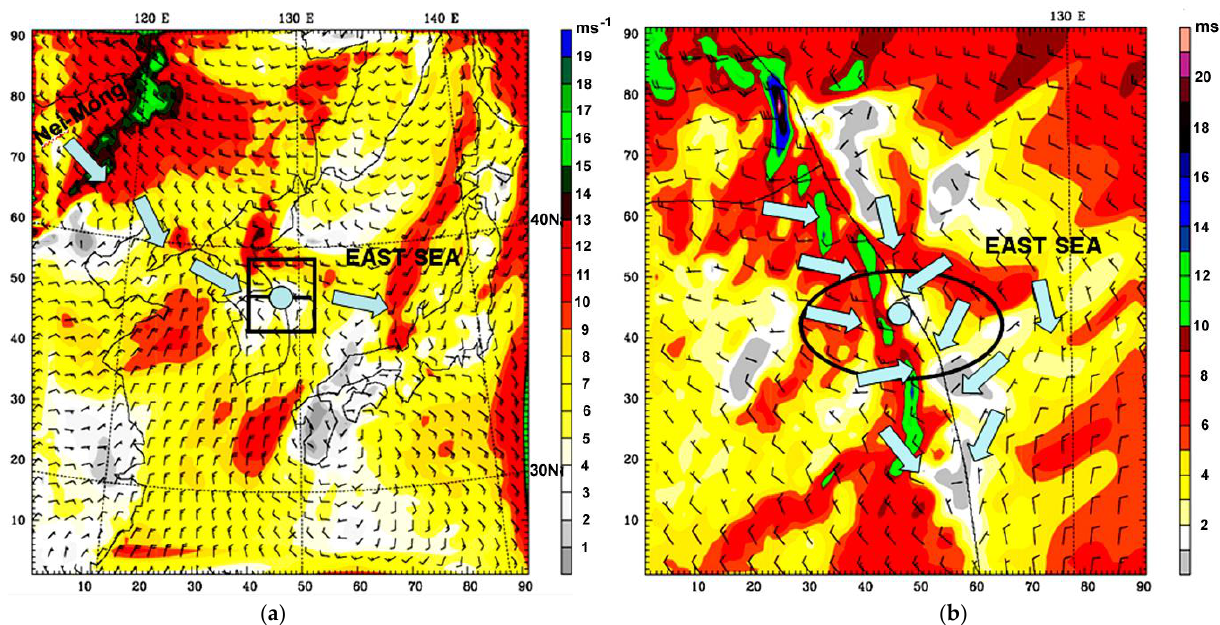
Figure 13. Surface wind (m/s) in ( a ) north-eastern Asia including Gangneung city on the Korean east coast (a small square; the first domain of WRF-3.6.1 model simulation) at 09:00 LST, 30 March 2004 and ( b ) the vicinity of Gangneung city (third domain), respectively. A small circle in ( a ) and ( b ), an arrow, and a large black circle denote Gangneung city, airflow, and the vicinity of Gangneung city of inland and coastal sea, respectively. The dusts from Nei-Mongo into the city by the northwesterly wind in ( a ) combined with pollutants emitted from the city and then were trapped by the easterly wind in ( b ).